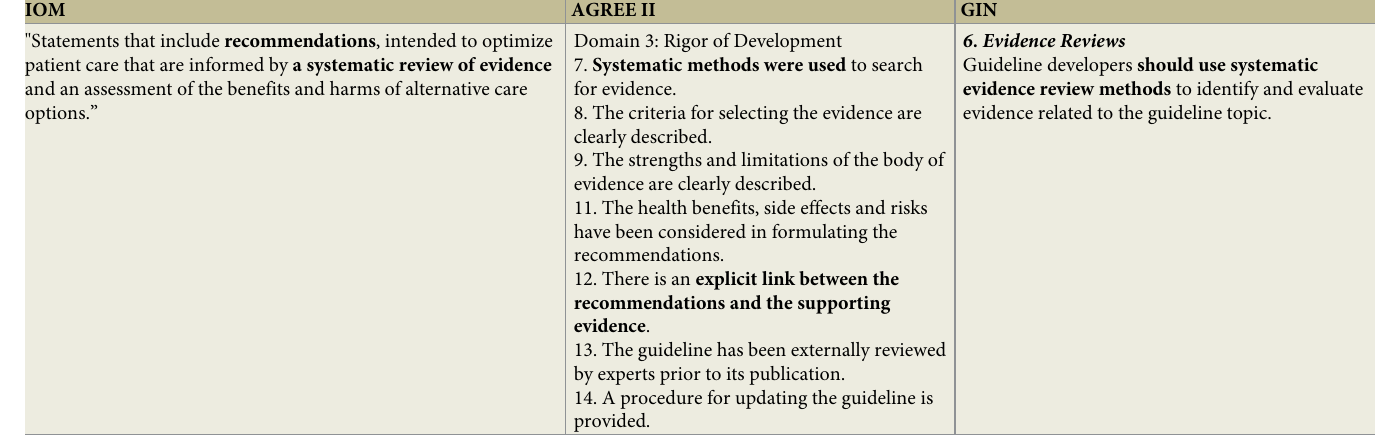
Table 1. Guidance on the evidence synthesis process in guideline development from IOM, AGREE II, and GIN. IOM AGREE II GIN "Statements that include recommendations , intended to optimize patient care that are informed by a systematic review of evidence and an assessment of the benefits and harms of alternative care